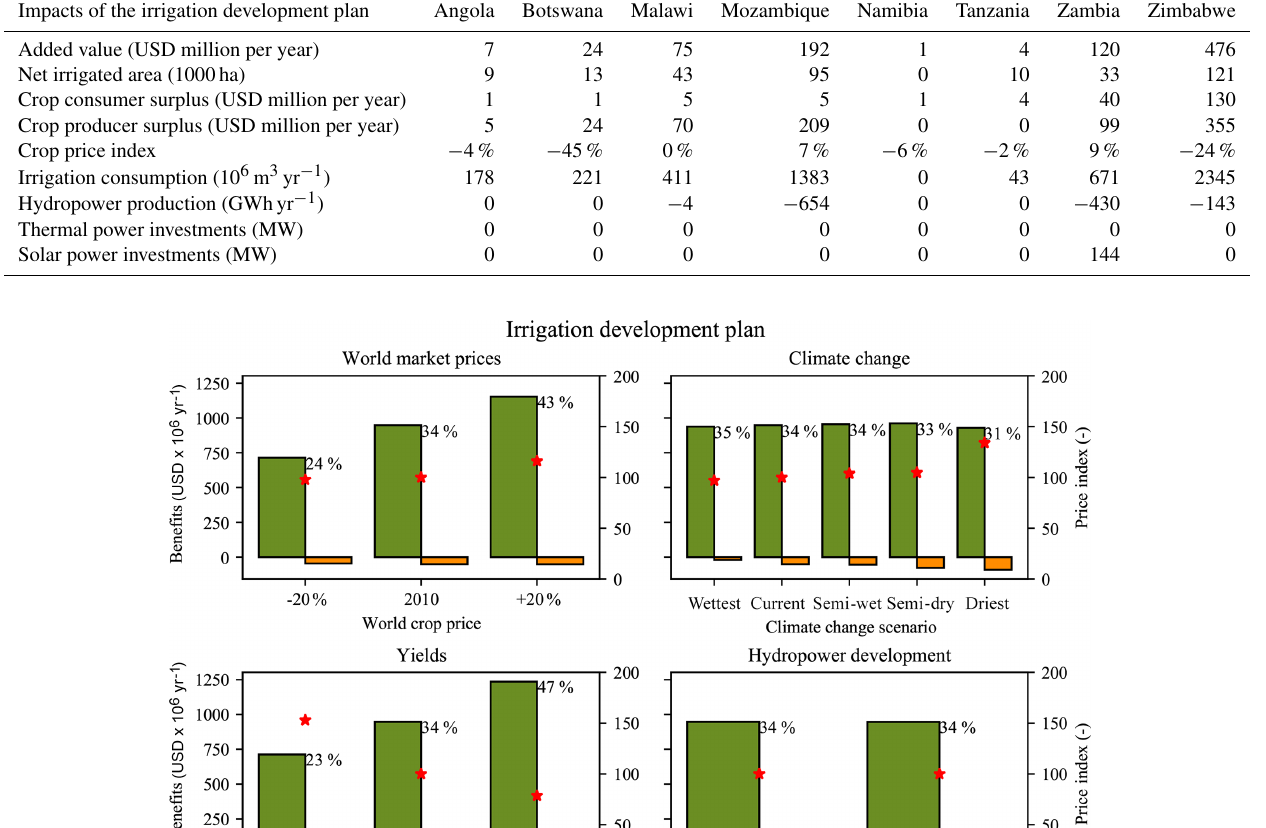
Table 13. Country-scale impacts of the irrigation development plan. Results are shown as the difference with and without the irrigation development plan for the 2030 scenario. The added value excludes construction costs. Impacts of the irrigation development plan